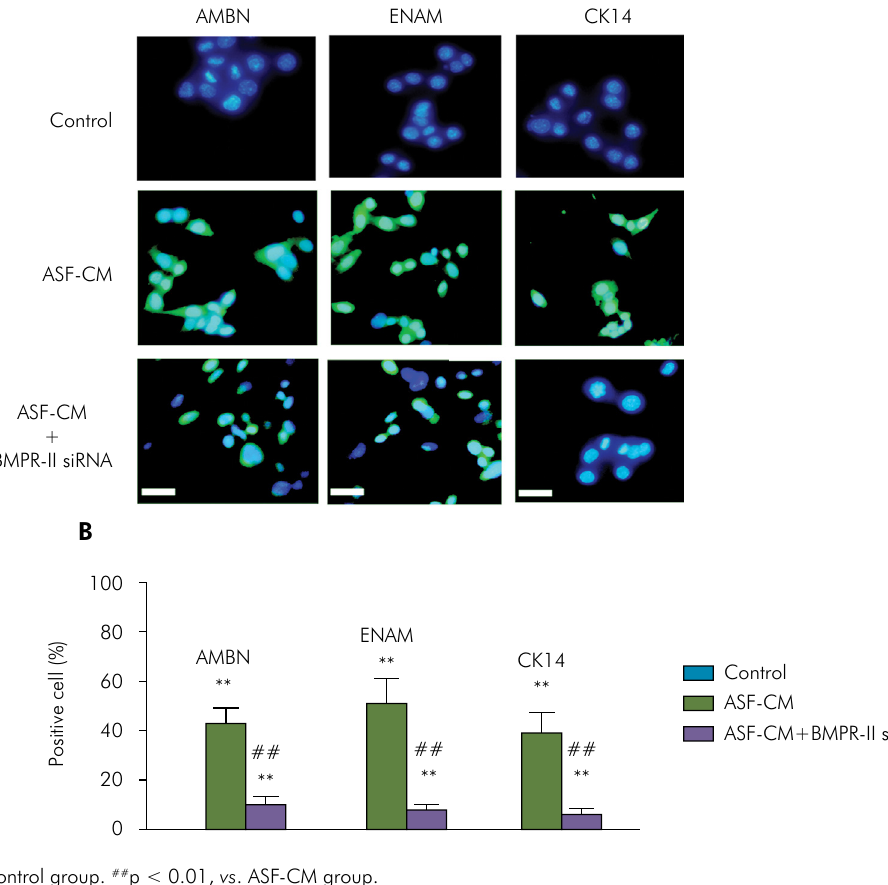
Figure 3. Immunofluorescent staining and quantification of the expression of AMBN, ENAM, and CK14 in iPS cells induced by the control medium, ASF-CM, or ASF-CM+BMPR-II siRNA. Scale bar represents 50 μ